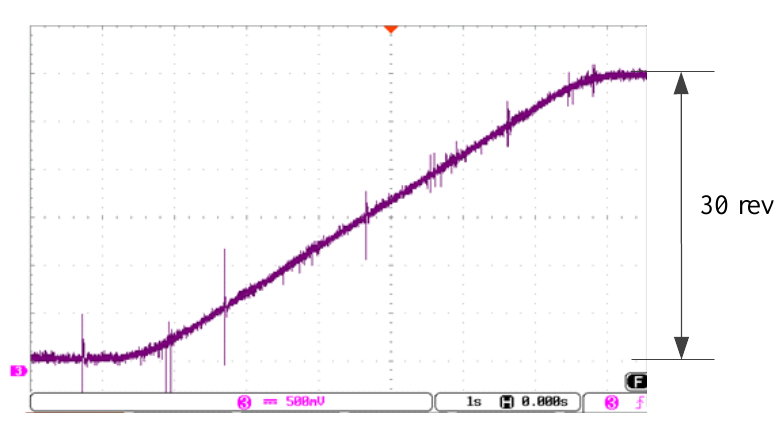
Figure 22. The position response (5 rev/div).